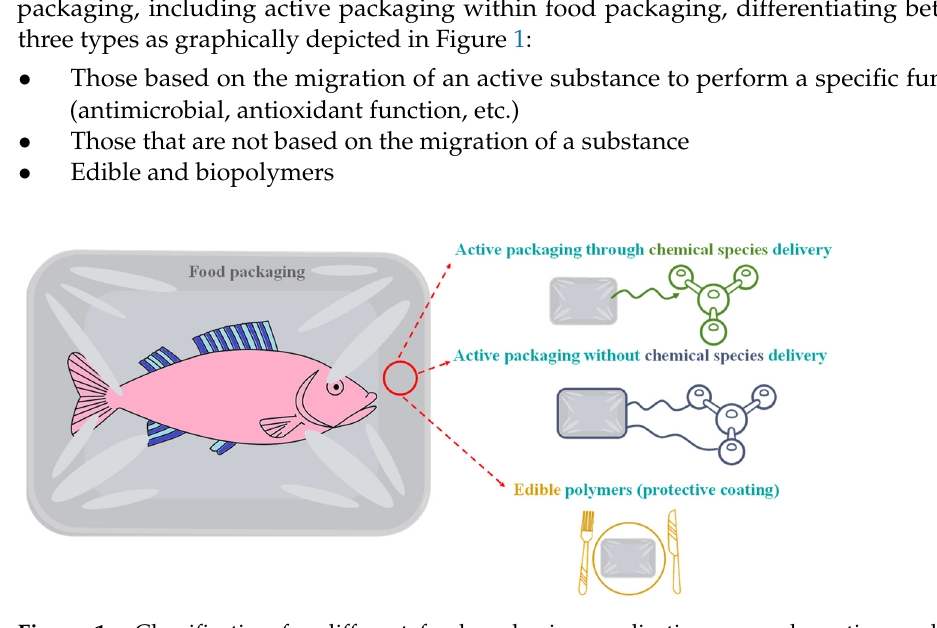
Figure 1. Classification for different food packaging applications, namely, active packaging through/without chemical species delivery and edible polymers.